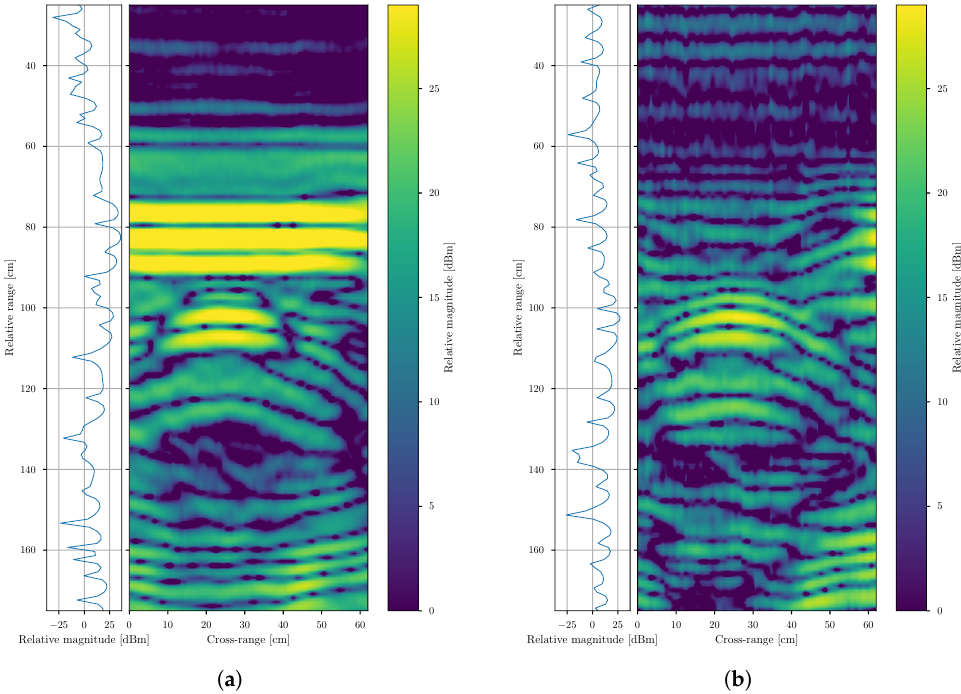
Figure 8. ( a ) Radargram with a homogeneous static target and a target of interest with EC system disabled and the corresponding slice left at 24 cm Cross-range. ( b ) Radargram with a homogeneous static target and a target of interest with EC system enabled and the corresponding slice left at 24 cm